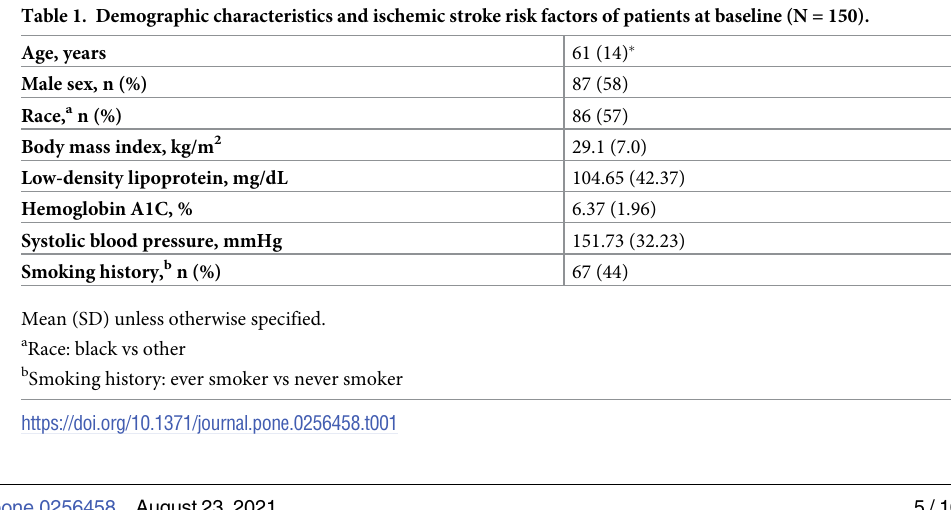
23/27 [85%]; large-artery occlusion 26/34 [76%]), while small-vessel strokes were more widely distributed (infratentorial 13/39 [33%]; supratentorial 24/39 [62%]; both 2/39 [5%]). On average, the patients were 61 years old (range 18–98 years), and the majority were male (N = 87, 58%) and black (N = 86, 57.3%; Table 1). The average patient in this population was pre-diabetic (mean HgA1C = 6.37 ± 1.97%), overweight (mean BMI = 29 ± 7 kg/m 2 ), and hypertensive (mean SBP = 151.73 ± 32.3 mmHg). Nearly half of patients (N = 67, 44%) either